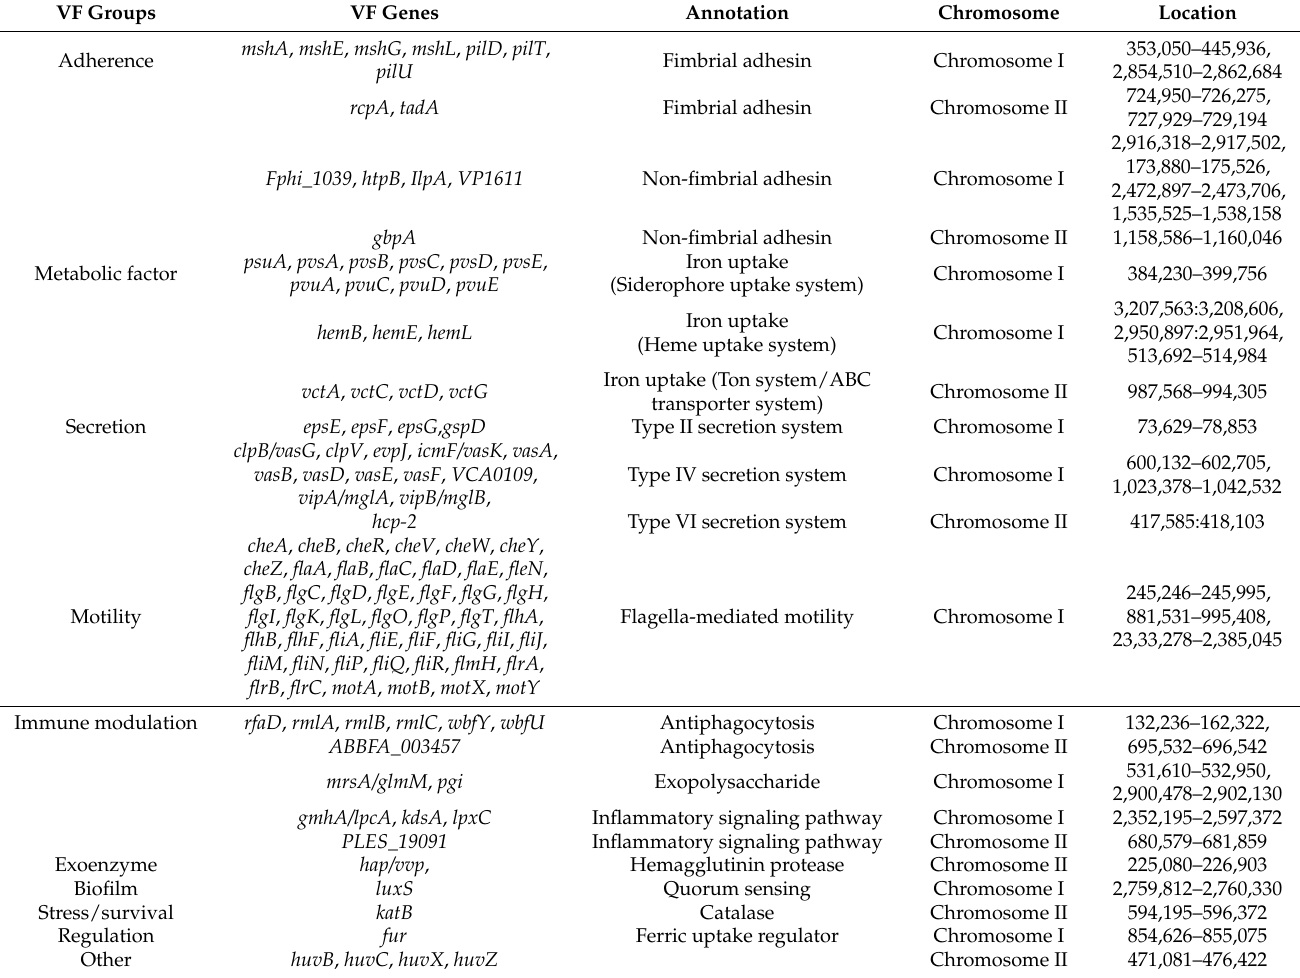
Table 2. Virulence factors of V. tubiashii